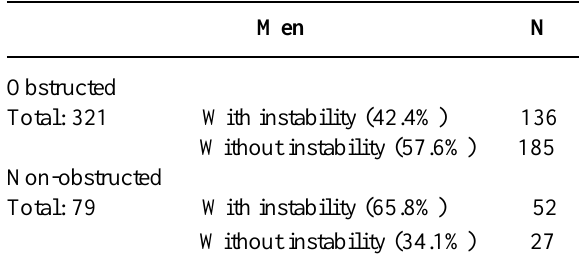
Table 1 – Prevalence of detrusor instability in 400 urodynamically evaluated